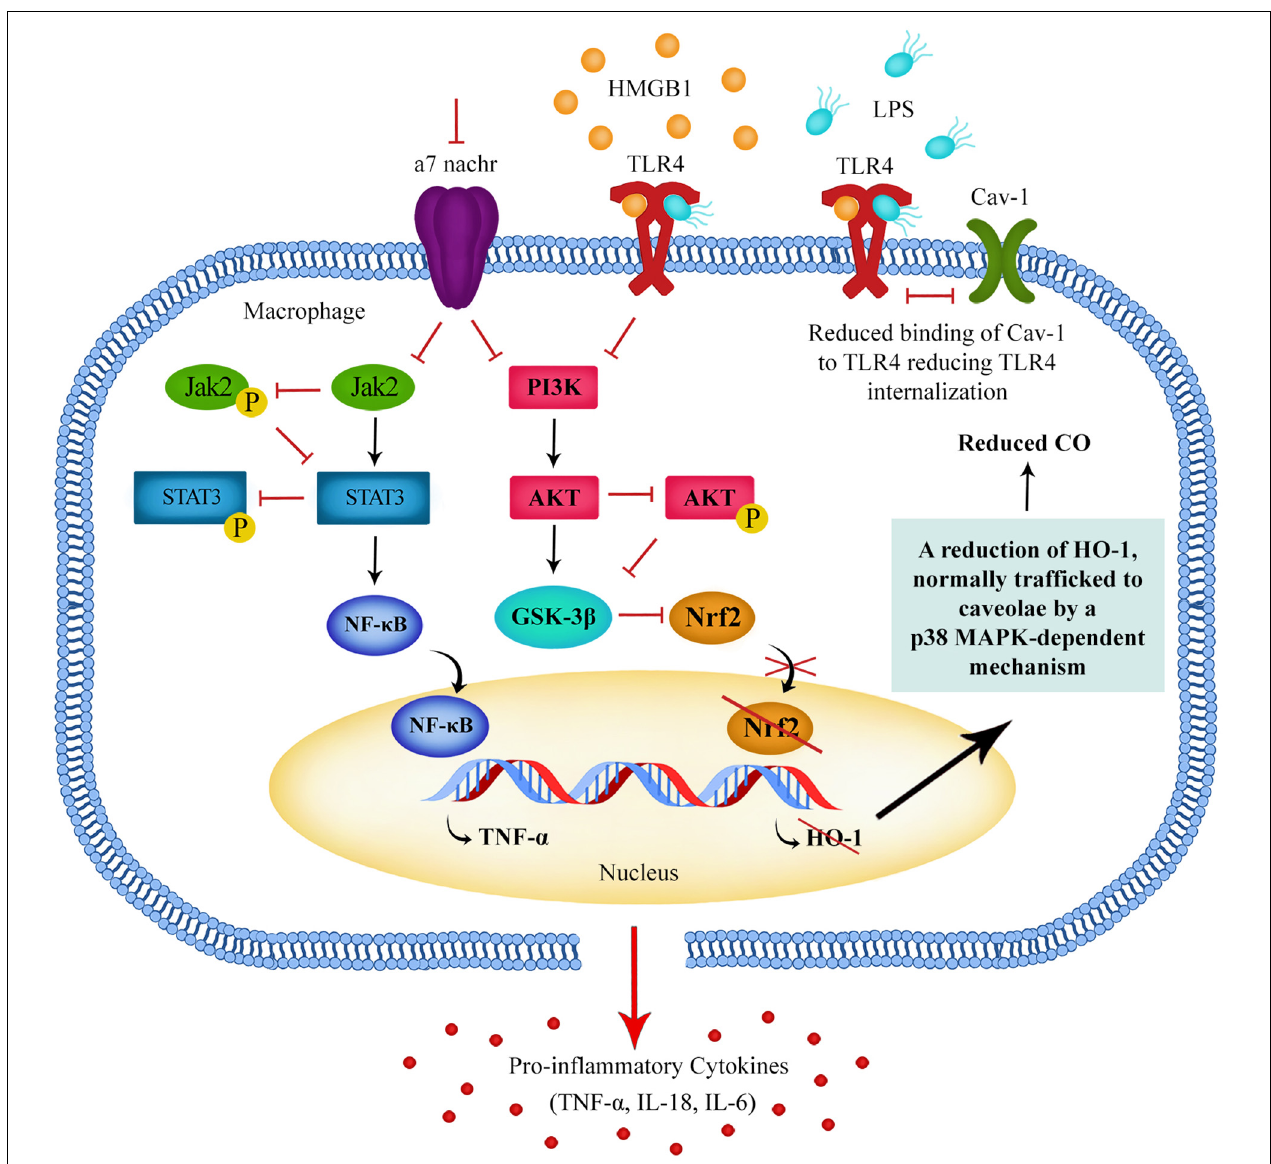
FIGURE 1 | Downregulation of the Jak2/STAT3 pathway and PI3K/Akt pathway in macrophages leads to a reduction of GSK3 β phosphorylation resulting in GSK3 β remaining in an active state. Active GSK3 β promotes the activation of NF-kB and the production of pro-inflammatory cytokines. These pathways can be regulated by α 7 nAChR activation and α 7 nAChRs can regulate TLR4 surface expression, possibly via a Nrf2-HO-1-CO-TLR4